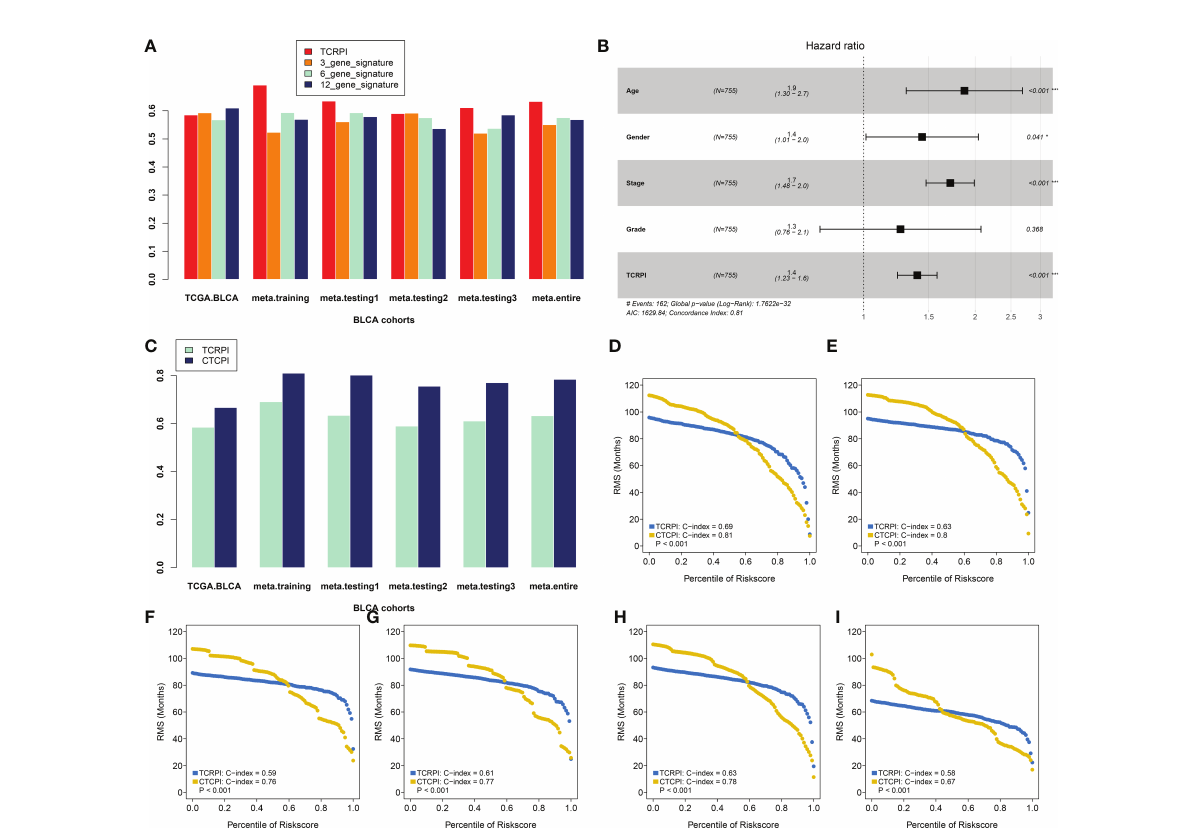
FIGURE 8 Construction of a Composite TCRPI and clinical prognostic index (CTCPI). (A) C-index comparison between TCRPI, 3-gene signature, 6-gene signature, and 12-gene signature. (B) Forest plot for the Hazard Ratios (HRs) of high vs low TCRPI risk groups via a meta-training cohort. (C) C-index comparison between TCRPI and CTCPI. Restricted mean survival (RMS) curves for continuous TCRPI and CTCPI in the meta- training cohort (D) , meta-testing cohort 1 (E) , meta-testing cohort 2 (F) , meta-testing cohort 3 (G) , meta-entire cohort (H) , and the TCGA-BLCA cohort (I) . NS, no signi fi cance, *P <0.05, ***P